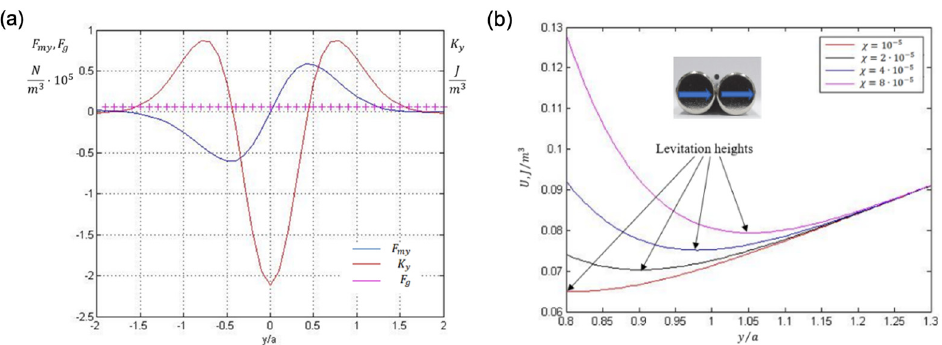
Figure 9. ( a ) Dependence of the y -component of magnetic force 𝐹 (cid:3040)(cid:3052) and the second derivative of the total energy K y = ∂ 2 U / ∂ y 2 on height y above the pair in the symmetry point ( x = 0, z = 0 ) . Gravitational force density F g = g ∆ ρ = 0.2 × 10 4 N/m 3 (with respect to suspension), ( χ p − χ ex ) = − 10 − 4 . ( b ) Total energy density vs. the distance ( y ) for different values of the diamagnetic susceptibility. The position of levitation is indicated by arrows. The wire parameters correspond to Figure 8. Inset shows the levitation configuration.